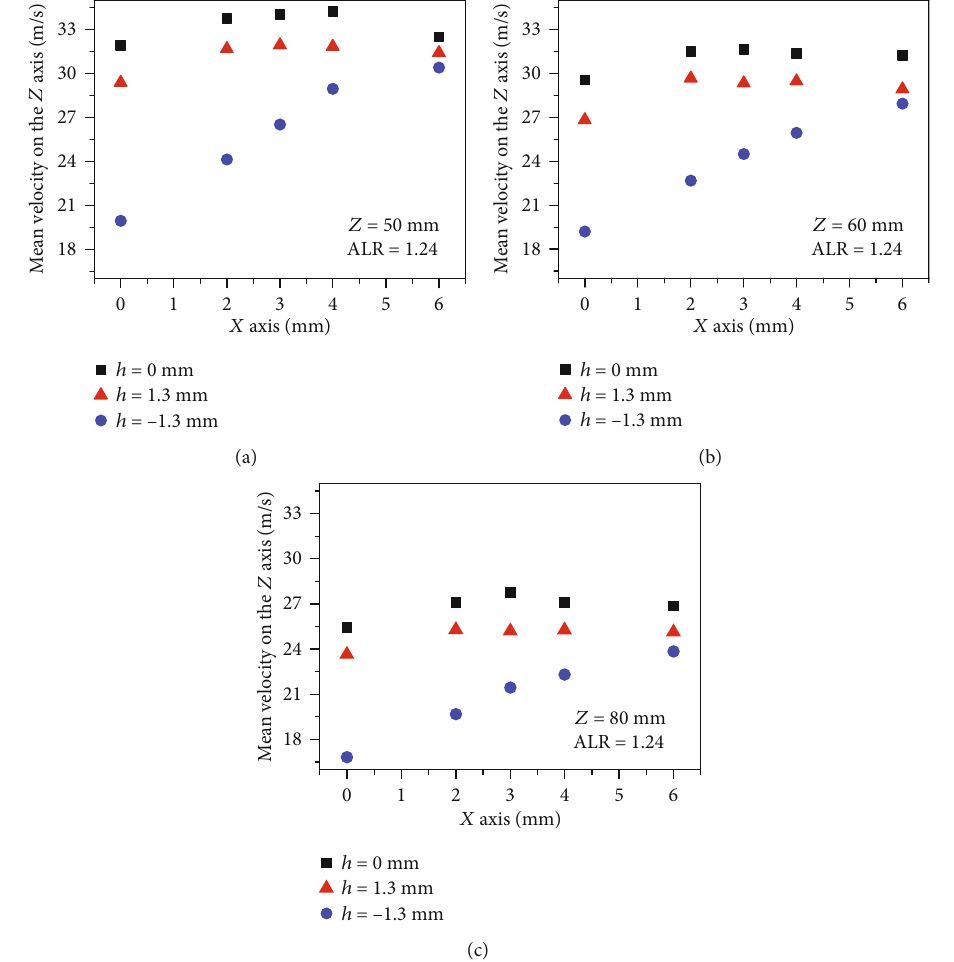
Figure 18: The droplet mean velocity on the Z axis of h series nozzle correlation at test position ( ALR = 1 : 24